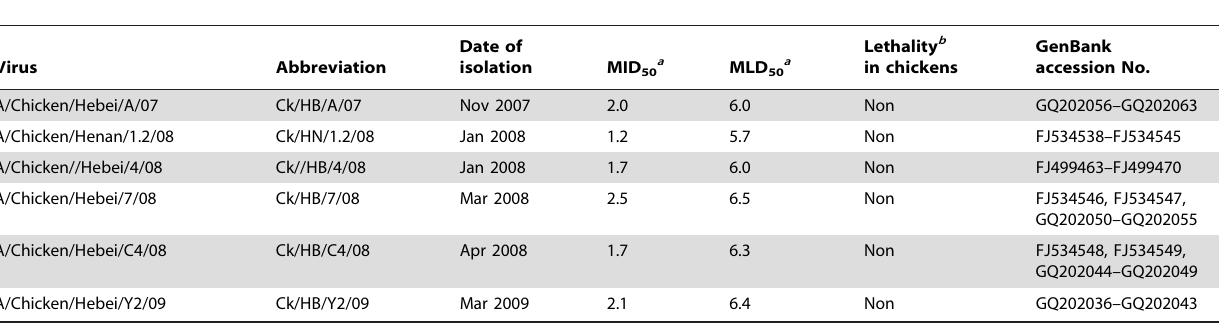
Table 1. Background information of avian influenza H9N2 viruses examined in this